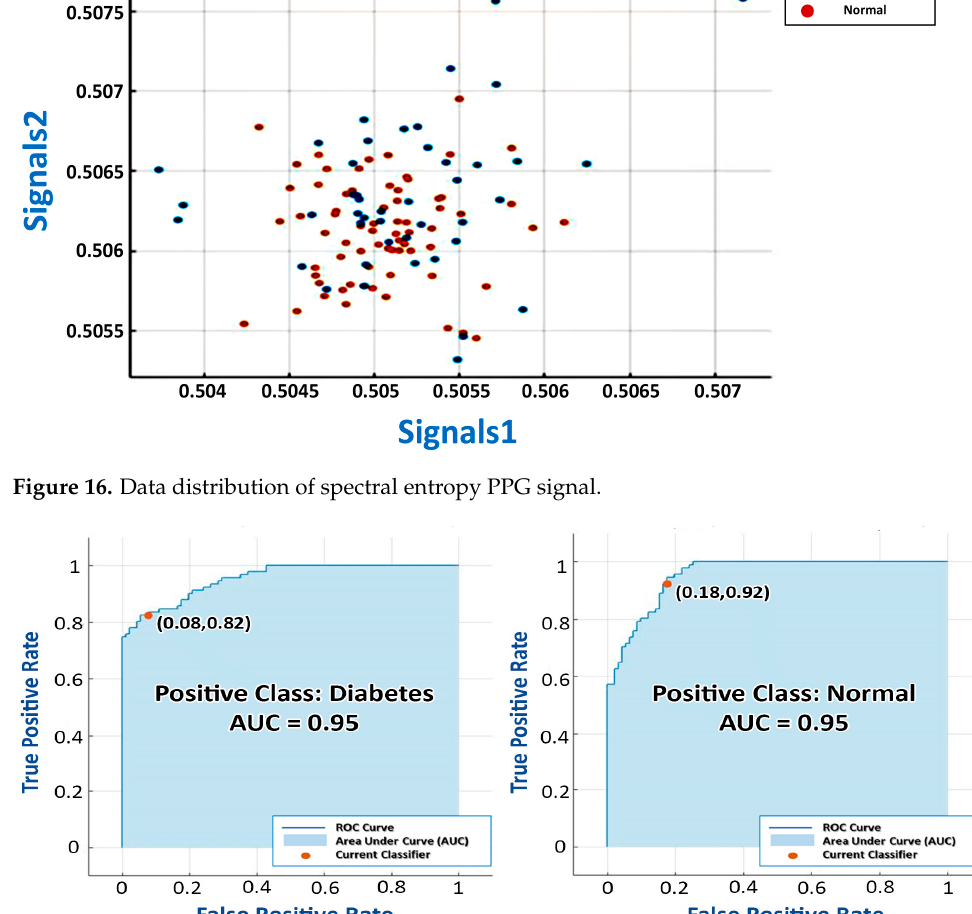
Figure 16. Data distribution of spectral entropy PPG signal. Table 6. Comparative analysis of training results.